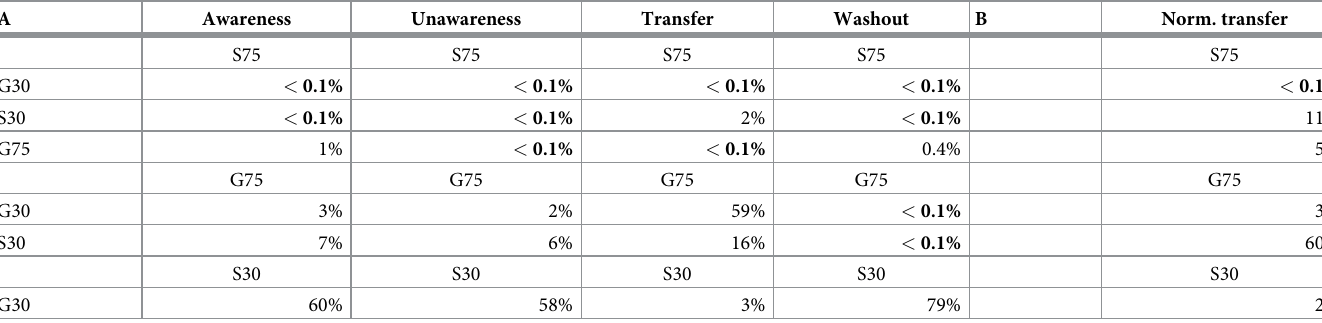
Table 2. Results of group